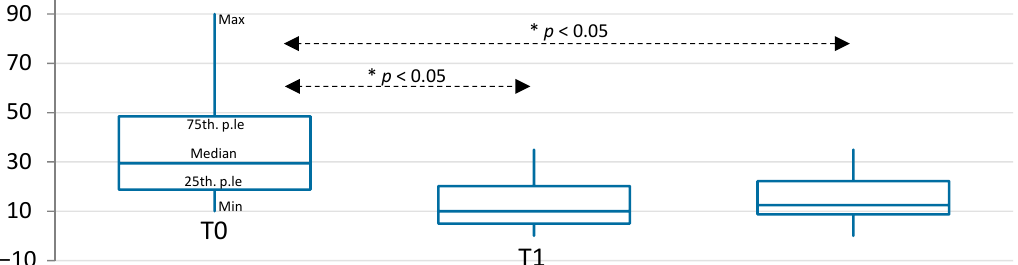
Figure 5. Box plots represent median, 25th and 75th percentiles of VAS scores for functional pain in the study group over time. * indicates statistically significant differences, p < 0.05.